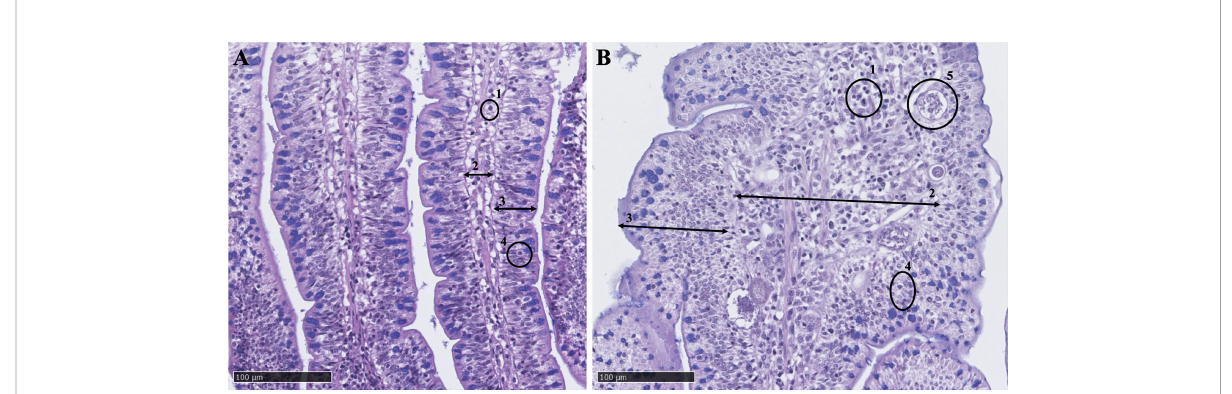
FIGURE 4 Photomicrography of ileum sections of pullets stained with hematoxylin and eosin. Alcian blue was used to stain goblet cells. (A) 1, Low ISI score of in fl ammatory cells in fi ltration in the lamina propria; 2, lamina propria thickness; 3, epithelial thickness; 4, in fl ammatory cells in fi ltration in the epithelium in pullets on P(OA+EO) group (200X). (B) 1, High ISI score of in fl ammatory cells in fi ltration in the lamina propria; 2, lamina propria thickness; 3, epithelial thickness; 4, in fl ammatory cells in fi ltration in the epithelium and 5, presence of oocysts in pullets in the control group